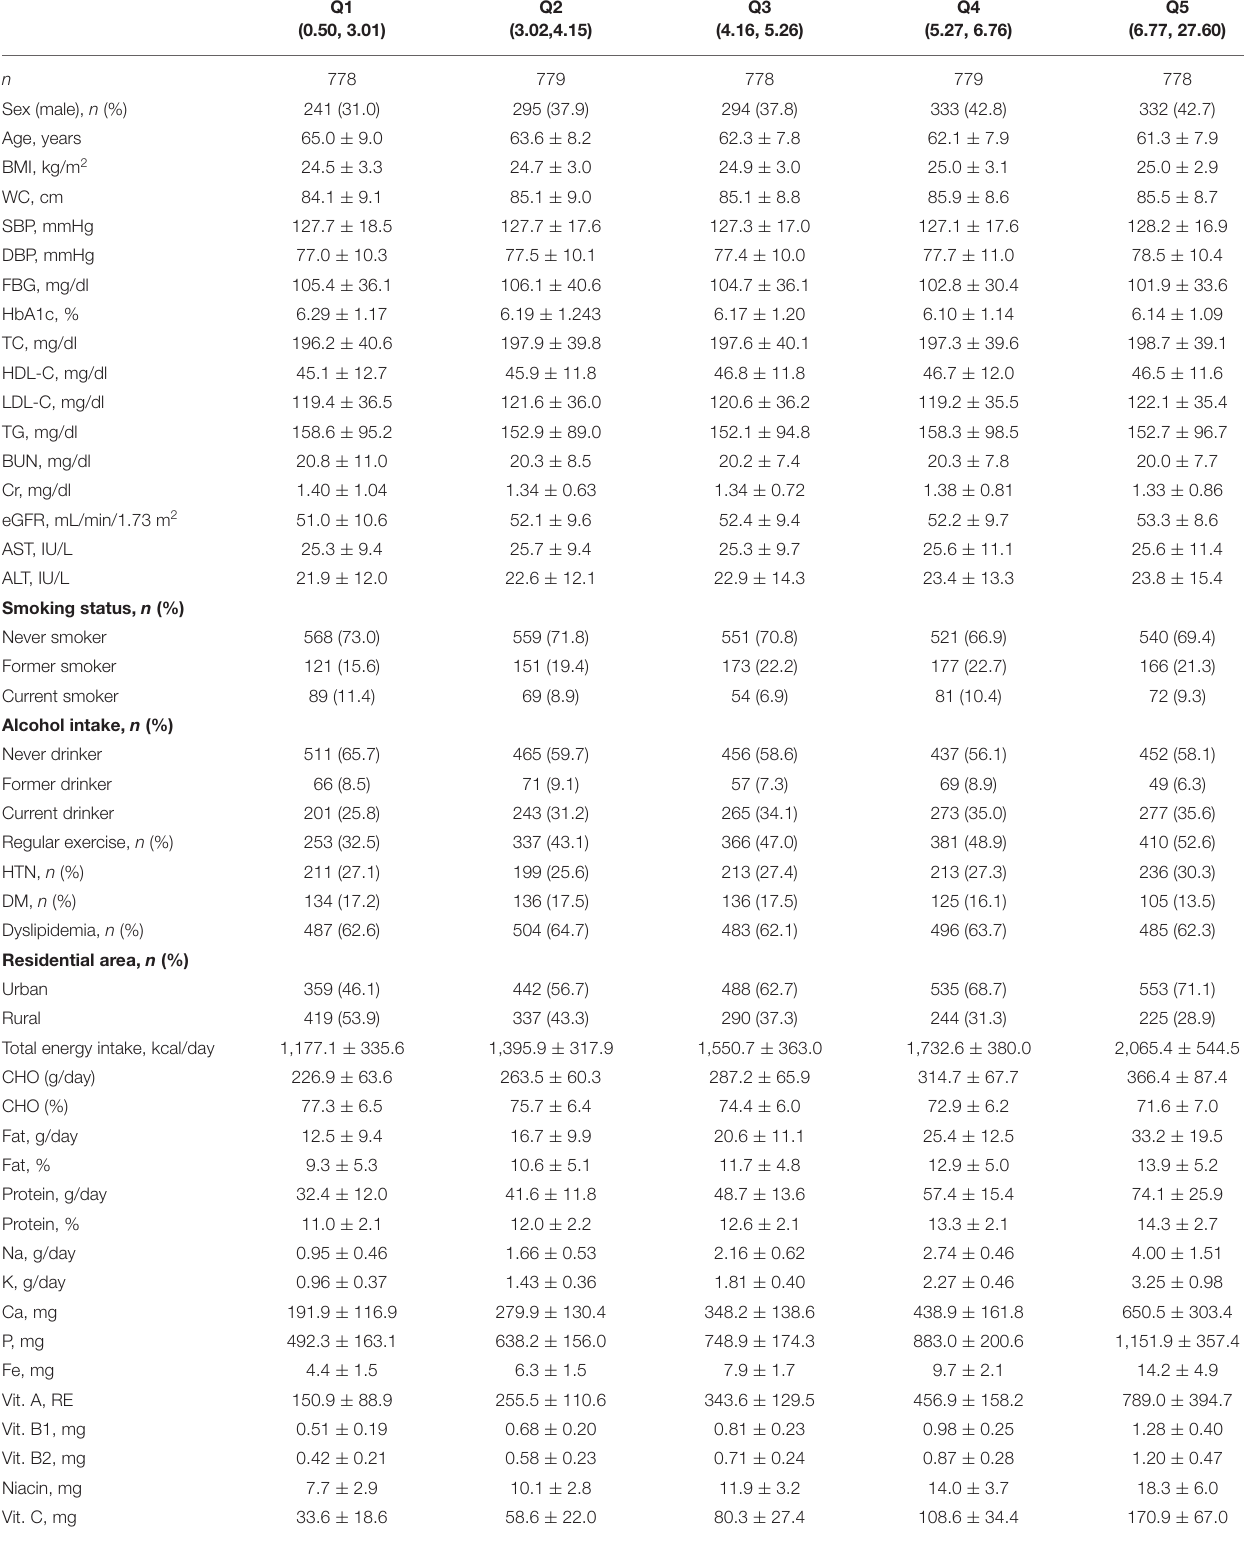
TABLE 1 | Baseline characteristics of the cohort according to dietary fiber intake